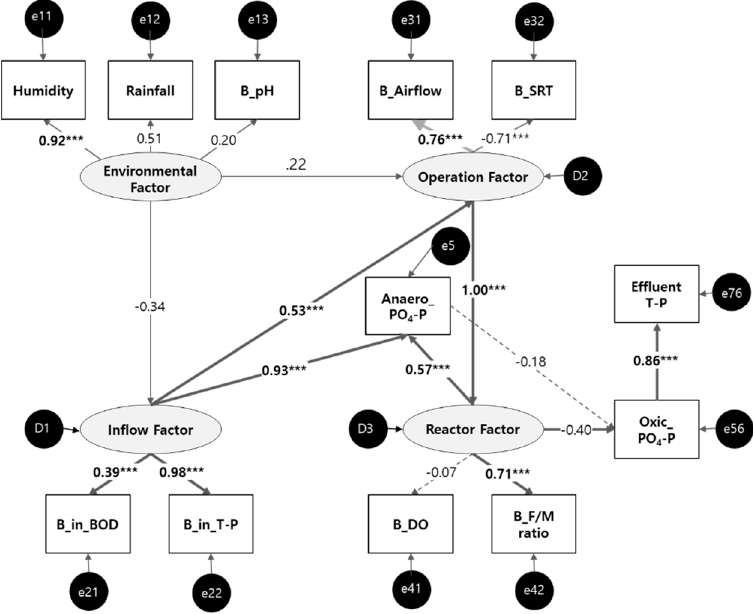
Figure 6. Structural equation model for effluent T-P concentration. Table 10. Fitness of the structural equation model for effluent